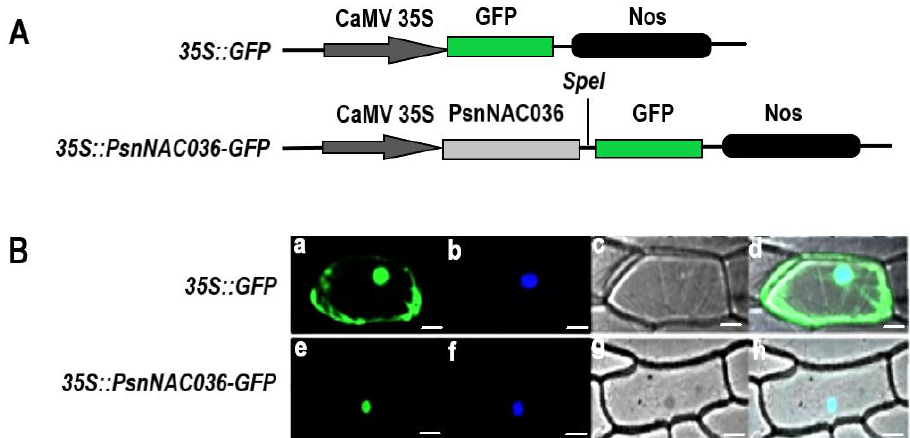
Figure 4. Subcellular localization of the PsnNAC036 protein. ( A ) Schematic map of the T-DNA inserted in the 35S::GFP binary vector. ( B ) The 35S::PsnNAC036-GFP fusion construct and the positive control 35S::GFP plasmid were introduced into onion epidermal cells by particle bombardment. GFP fluorescence was observed by confocal laser scanning microscopy. ( a , e ) are fluorescence images observed in a dark field (green); ( b , f ) are 2-(4-Amidinophenyl)-6-indolecarbamidine dihydrochloride (DAPI) staining, which is specific for the nucleus (blue); ( c , g ) are light images observed in bright field; ( d , h ) are merged images of dark field and bright field. Scale bar = 20 µ